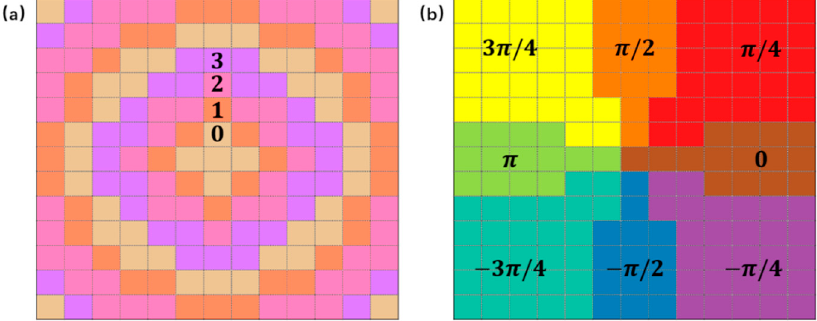
Figure 4. ( a , b ) Colors indicating the phase change of the two encoding methods.